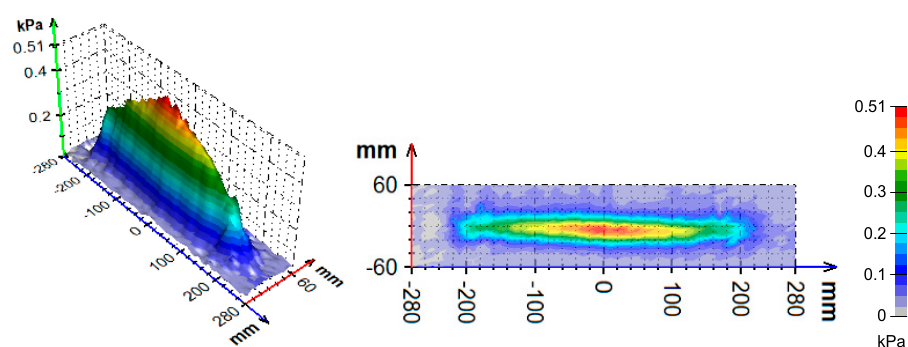
Figure 8. Impact pressure distribution for experiment E3.